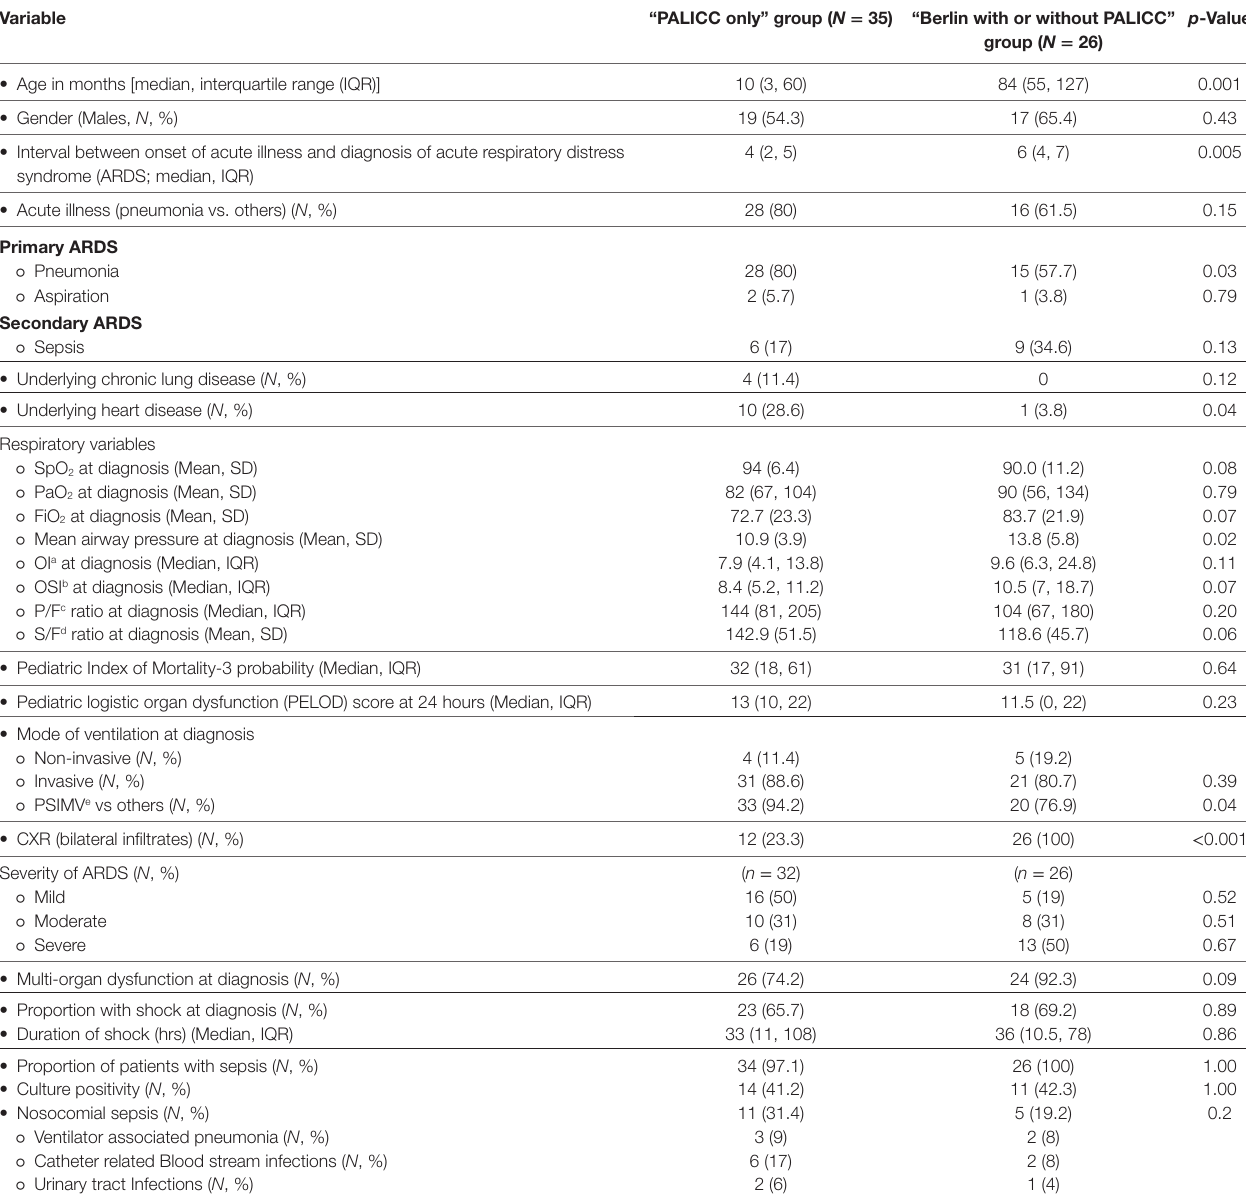
TaBle 1 | Baseline characteristics of patients in the “PALICC only” and the “Berlin with or without PALICC” definition groups. Variable “Palicc only” group ( N = 35) “Berlin with or without Palicc”